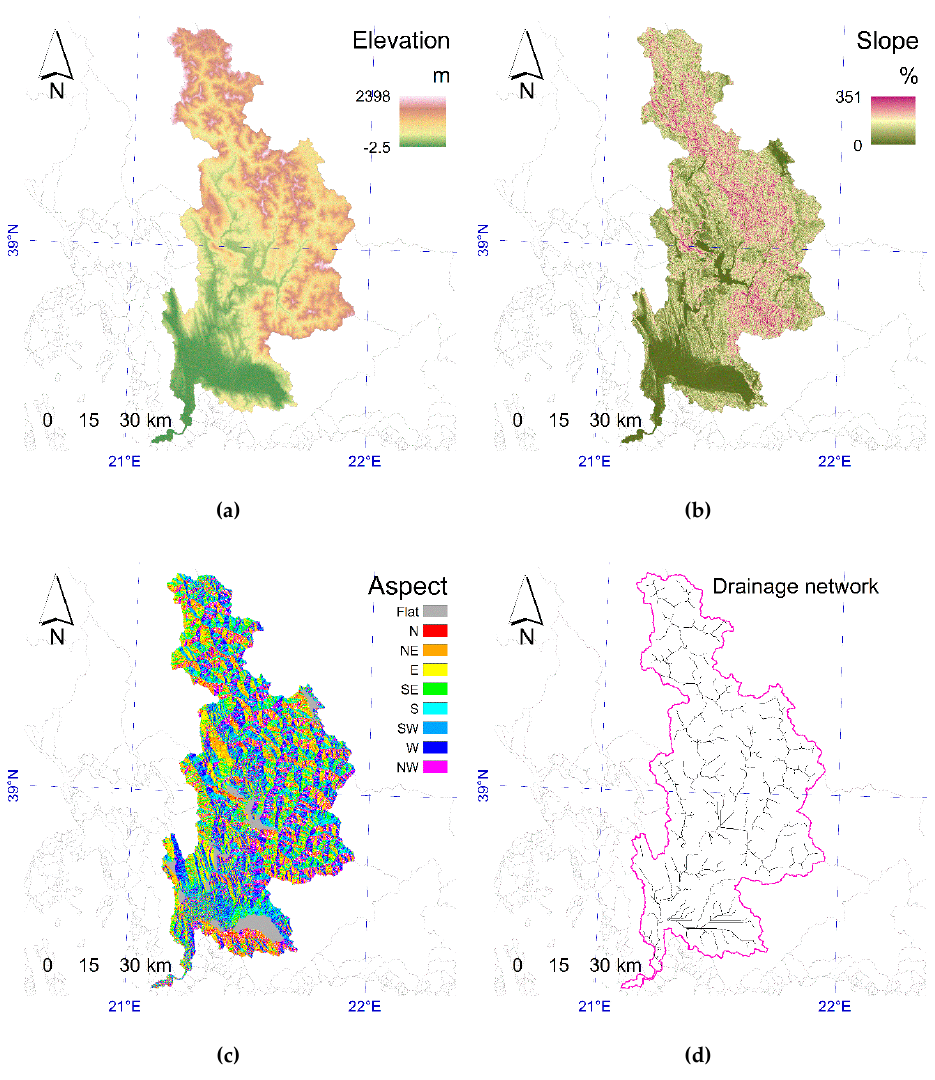
Figure 5. Topographic and hydrographic maps of the Acheloos river basin: ( a ) elevation; ( b ) slope; ( c ) aspect; ( d ) drainage network (derived with FAT=10,000). Table 2. Statistics, properties, and metrics of the main topographic and hydrographic features computed for the two experimental river basins.